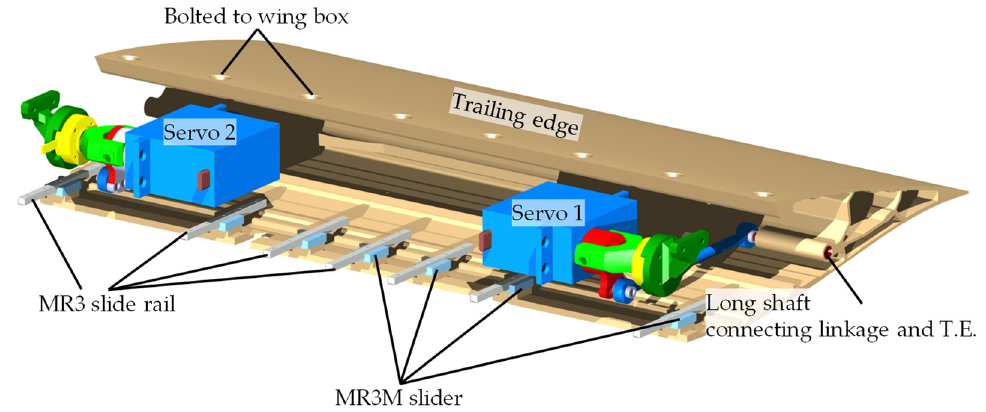
Figure 8. The compliant mechanisms–actuation–sensor subsystem of mTE4.